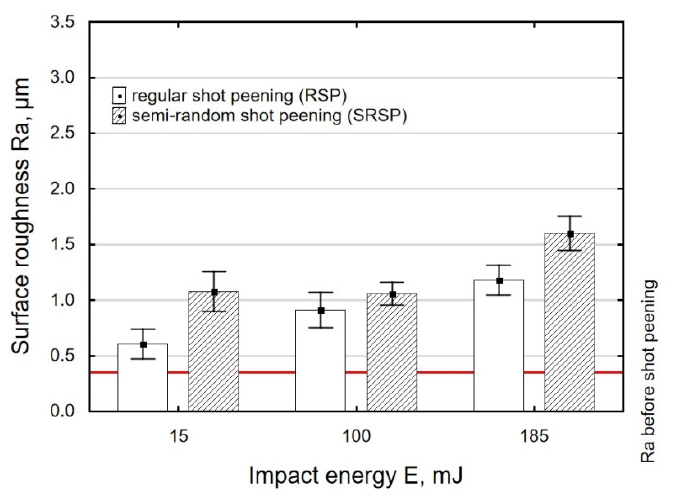
Figure 11. Impact energy versus roughness parameter Ra (ball diameter D = 10 mm, distance between dimples x = 0.3 mm).